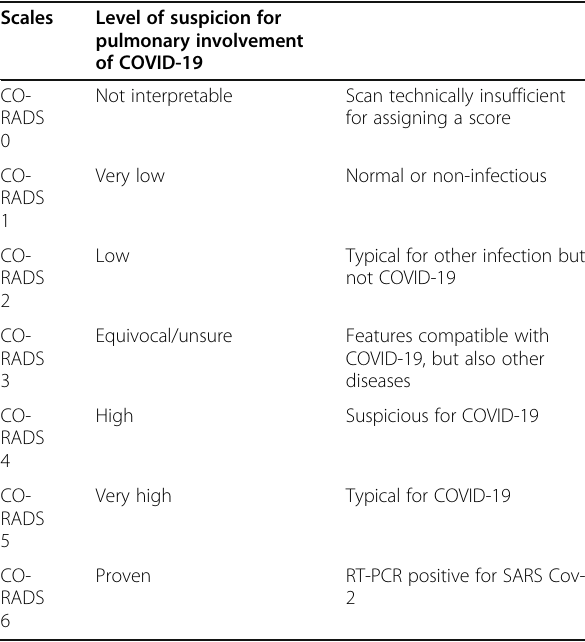
Table 1 Scales of COVID-19 Reporting and Data System CO- RADS (CO-RADS) and the corresponding level of suspicion for pulmonary involvement in COVID-19